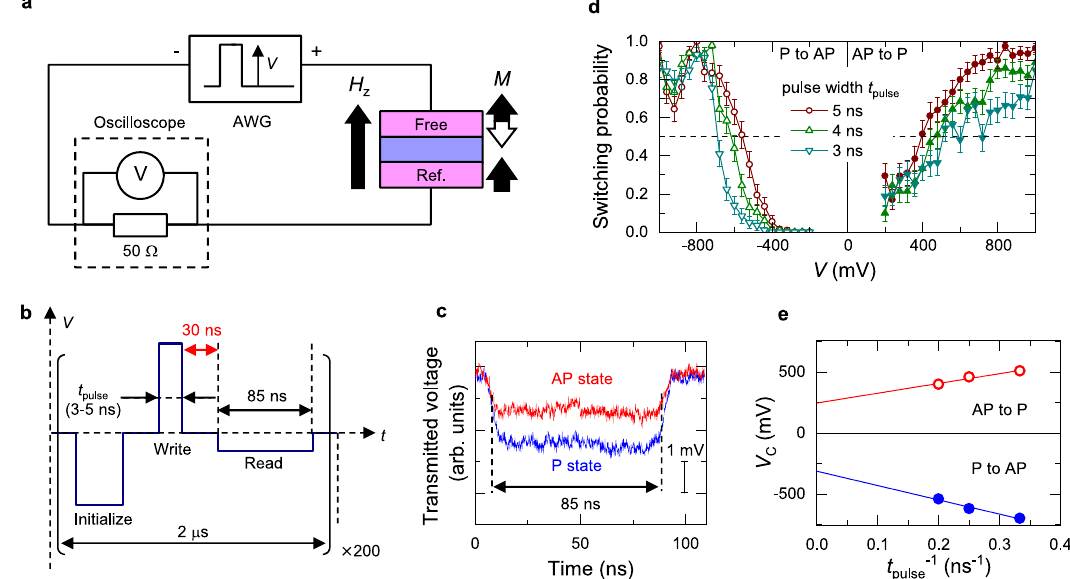
Fig. 3 Spin-transfer torque switching. a Circuit con fi guration to measure spin-transfer-torque (STT) switching probability of low thermal stability factor MTJs. b Schematics of voltage waveform applied to MTJs. c Transmitted voltage monitored at oscilloscope during read sequence with a duration of 85 ns. d Switching probability as a function of pulse voltage amplitude V with different write pulse duration t pulse . e Switching voltage V C as a function of t pulse − 1 . Lines are linear fi ts, whose intercept yields intrinsic critical voltages V C0,P(AP)